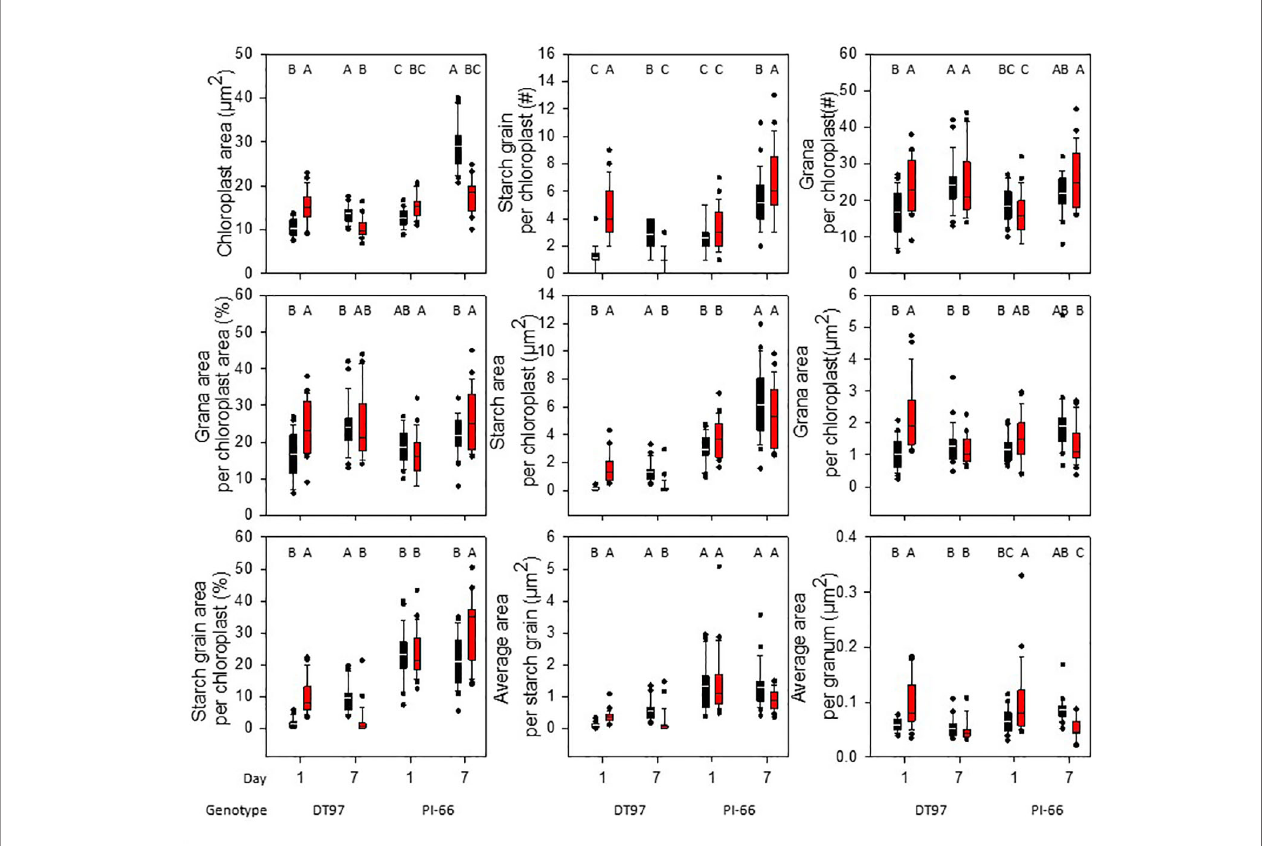
FIGURE 5 | Chloroplast ultrastructure characteristics in upper-most fully expanded leaves of DT97 and PI-66 from the 1 st and 7 th day of 28 and 45°C temperature treatments. Traits were assessed on transmission electron microscopy images of 25 chloroplasts for each time point and temperature treatment of both genotypes (N = 25). Lines within boxes represent the median and top and bottom of whiskers represent the 1 st and 3 rd quartiles respectively. Circles represent outlier data one and a half times the 1 st and 3 rd quartiles. Letters indicate similar treatments of phenotypes within genotype based on Tukey pairwise